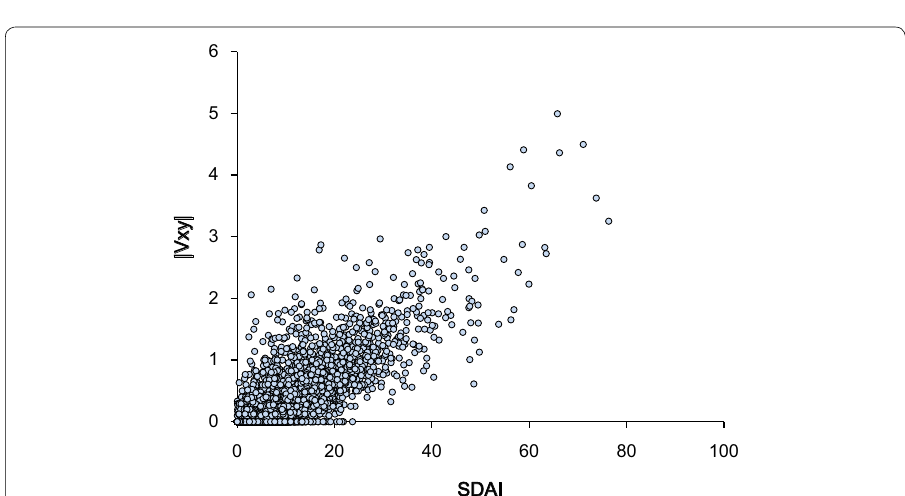
Fig. 4 Scatter plots between |Vxy| and Simplified Disease Activity Index (SDAI). The correlation coefficient between |Vxy| and SDAI was 0.82 ( p <